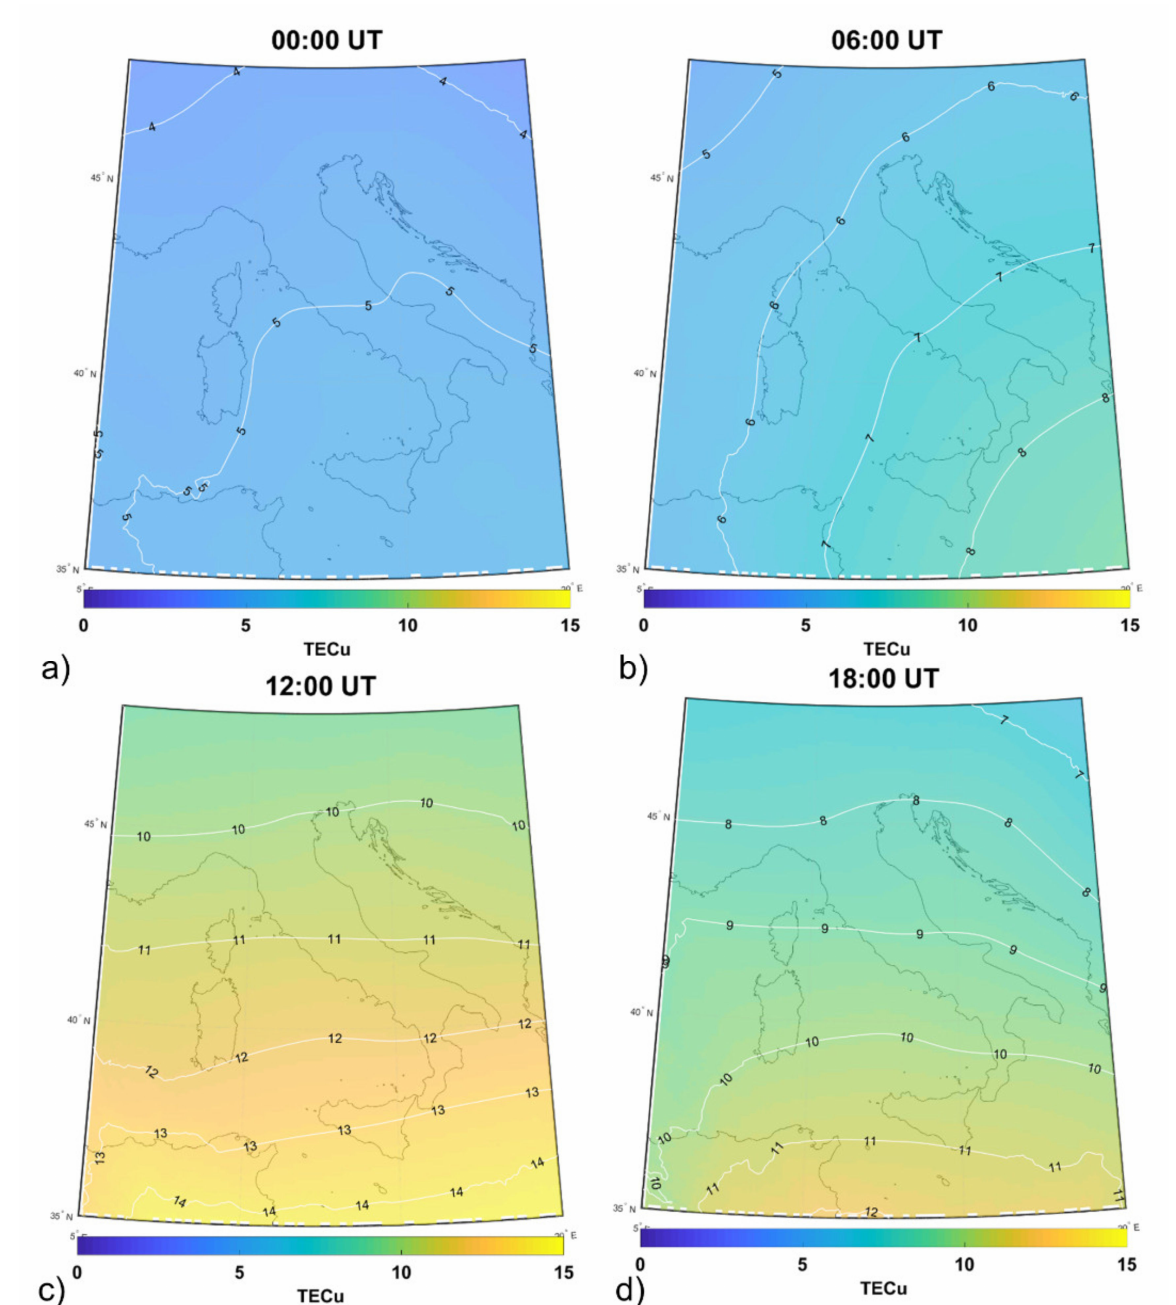
Figure 7. Maps of mean TEC at 00:00 UT (panel a ), 06:00 UT (panel b ), 12:00 UT (panel c ) and 18:00 UT (panel d )